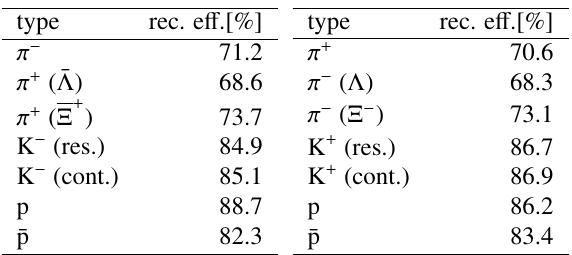
Table 3. Reconstruction e ffi ciencies for the final state particles + Λ from ¯pp → Ξ K − (left) and ¯pp → Ξ − ¯ Λ K + (right). The statistical error is σ ≈ 0 . 1%.